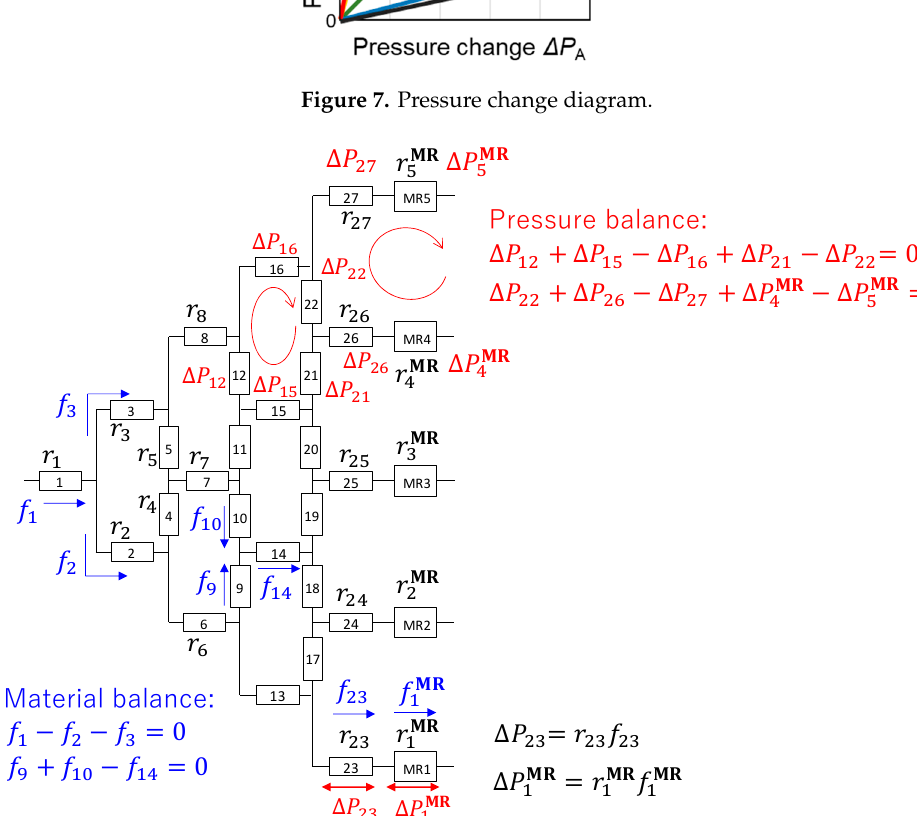
Figure 8. Model of SRFD with five parallelized MRs.